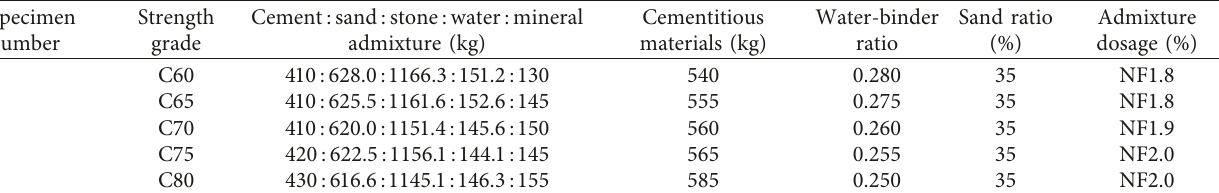
Table 2: Mix ratios of C60, C65, C70, C75, and C80 HSHPC.